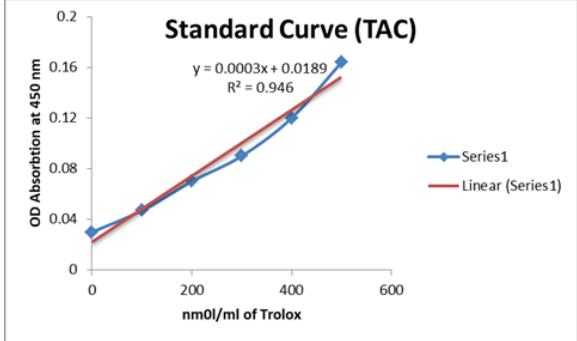
Figure 2. The standard curve for determining the total antioxidant capacity (TAC) by CUPRAC